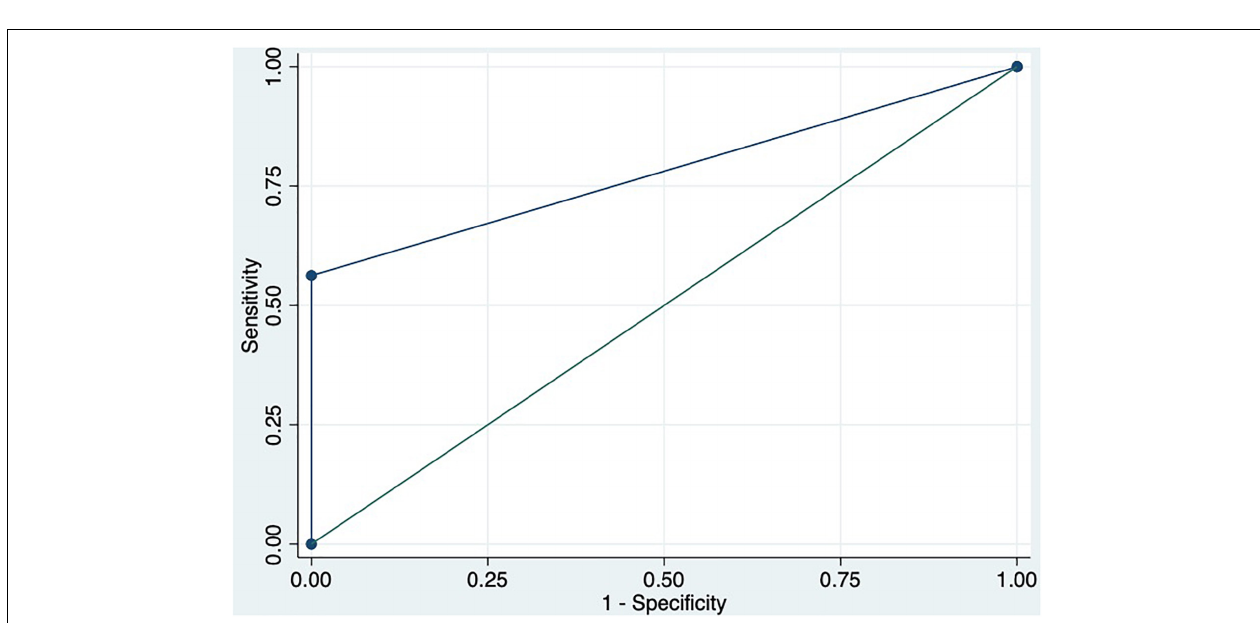
FIGURE 4 | ROC curves of spleen TE and damping index to predict chronic response to beta-blockers.